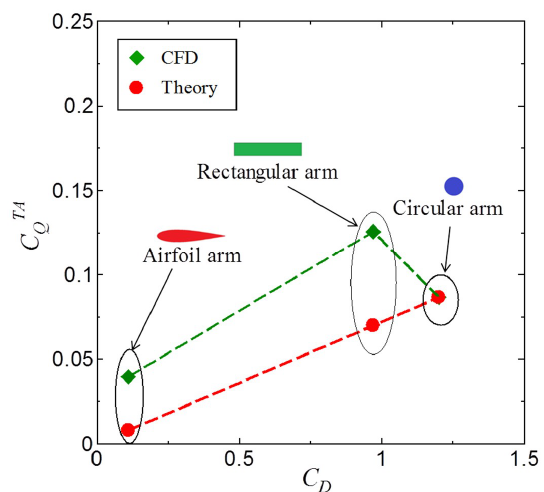
Figure 8. Drag coefficient dependence of total arm torque coefficient in the condition of λ = 3. Figure 8. Drag coe ffi cient dependence of total arm torque coe ffi cient in the condition of λ = 3.